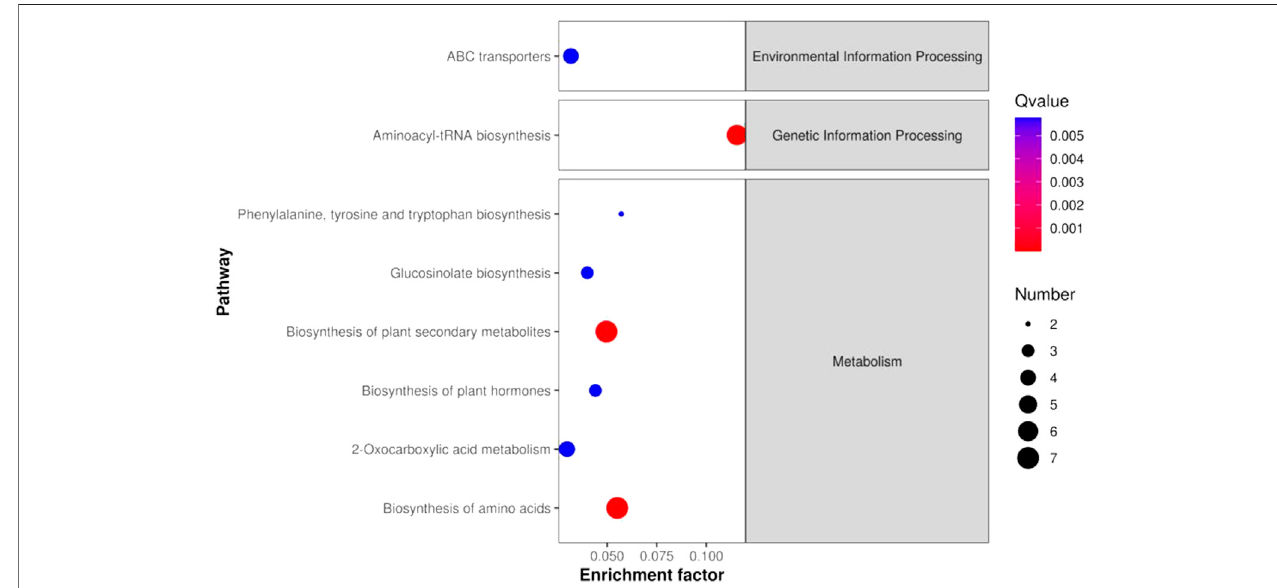
FIGURE 13 | The result of differential metabolite enrichment